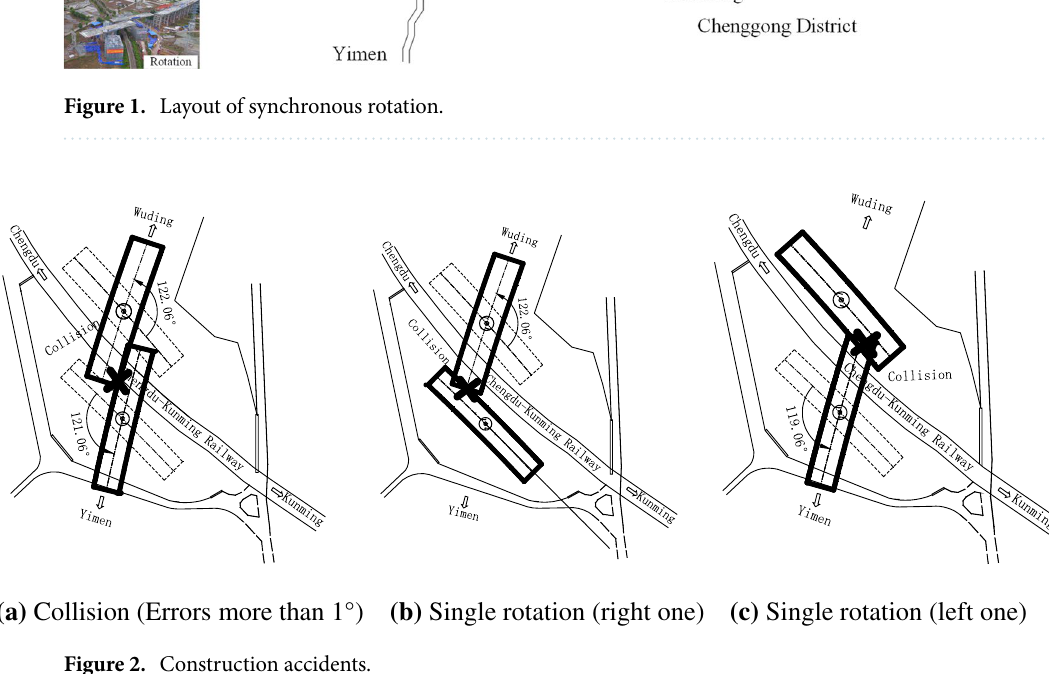
Figure 2. Construction